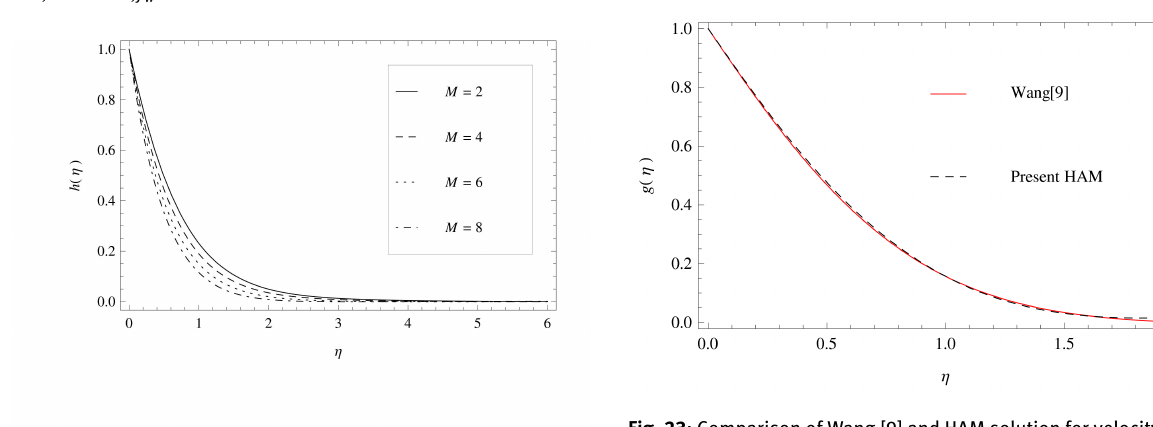
Fig. 23: Comparison of Wang [9] and HAM solution for velocity func- tion g ( η ) disk surface. The effects of parameters on an induced ve- locity component k ( η ) can be perceived from Figs. 12 – 16. Fig. 12 depicts that the increasing values of α rises k ( η ) near the disk surface then decline exponentially and tends to zero as the values are approaching to infinity. The